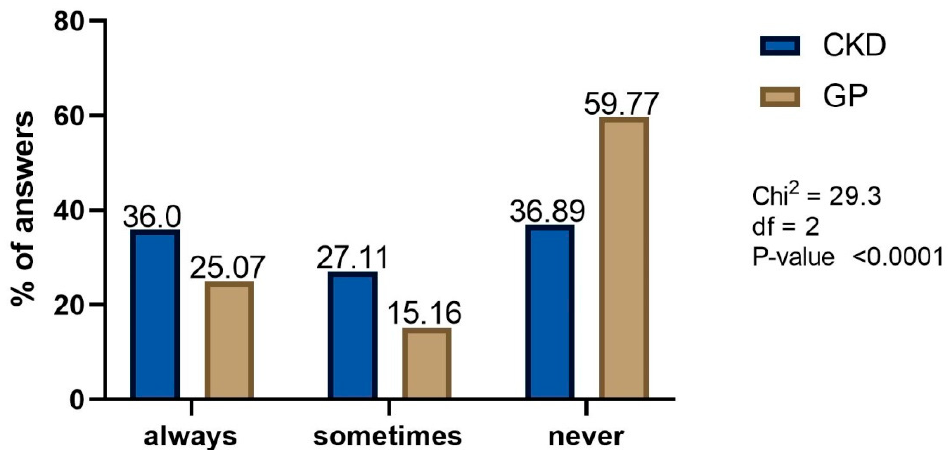
Figure 7. Frequency of medical advice before taking NSAIDs or analgesics .